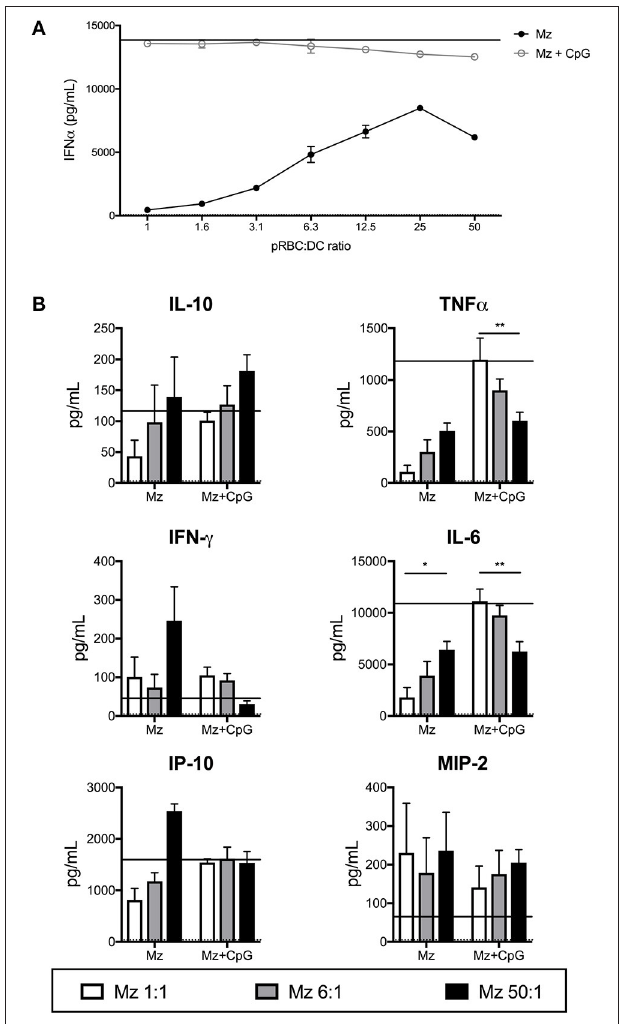
FIGURE 5 | Merozoites induce expression of a range of cytokines from FL-DCs. FL-DCs were incubated for 18h with merozoites (Mz) and cytokines were measured in the supernatant using FlowCytomix and ProcartaPlex multiplexes. (A) High ratios of Mz:DCs induce high expression of IFN- α . (B) Mz:DC ratios of 1:1 (white bars), 6:1 (gray bars), or 50:1 (black bars). The expression in response to media alone (dotted line) and CpG2216 alone (solid line) were included for comparison. * p < 0.05, ** p < 0.01. P -values were determined by two-way ANOVA using multiple comparisons. Figure